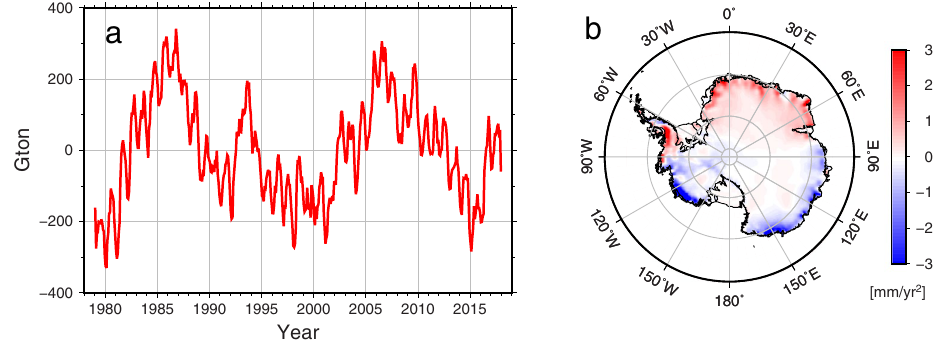
of acceleration rate of accumulated precipitation. Acceleration rates are estimated from the second order 1 a 2 t 2 ) fitting to accumulated precipitation. Figures are created with Generic Mapping polynomial ( a 0 + a 1 t + 2 Tools (GMT-5.4.5, https ://gmt.soest .hawai